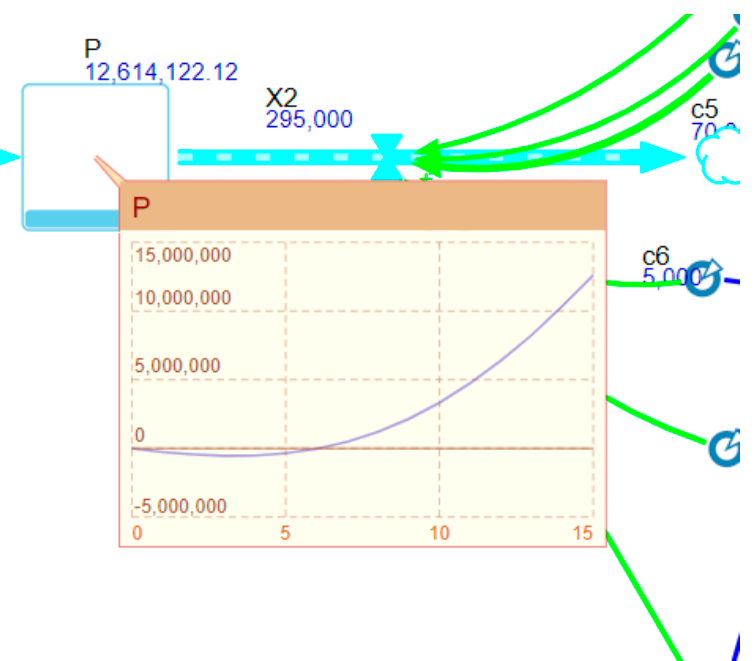
Figure 13. The graph showing how the profit of the vertical farm changes during the simulation process, RUB. Source : designed by authors.